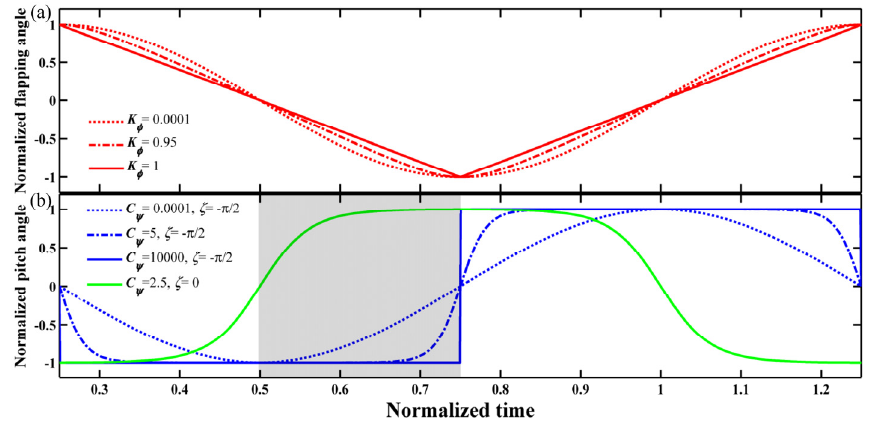
Figure 4. The wing kinematic pattern: ( a ) flapping angle changed with K φ ; ( b ) pitch angle is regulated by with C ψ . ζ is limited in gray region.